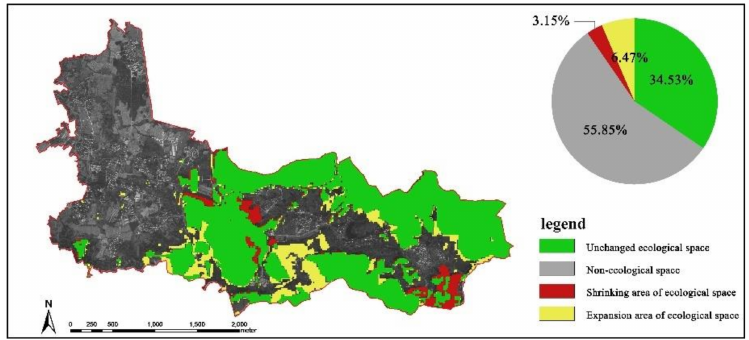
Figure 11. Shrinking and expansion areas of ecological space in 2030.